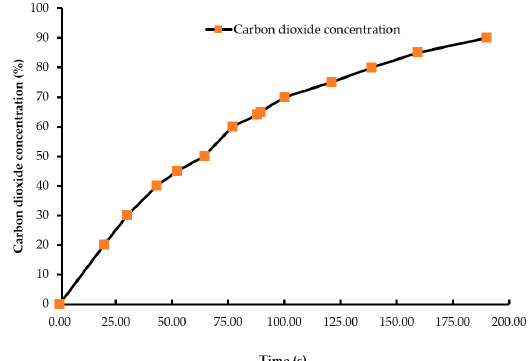
Figure 1. Carbon dioxide wash-in curve (concentration vs. time). The carbon dioxide concentration in the beginning of the treatment was 0.04% which increased to 90% as the chamber was being filled by carbon dioxide gas. An infrared CO 2 sensor measured the gas concentration inside the chamber during the experiment.